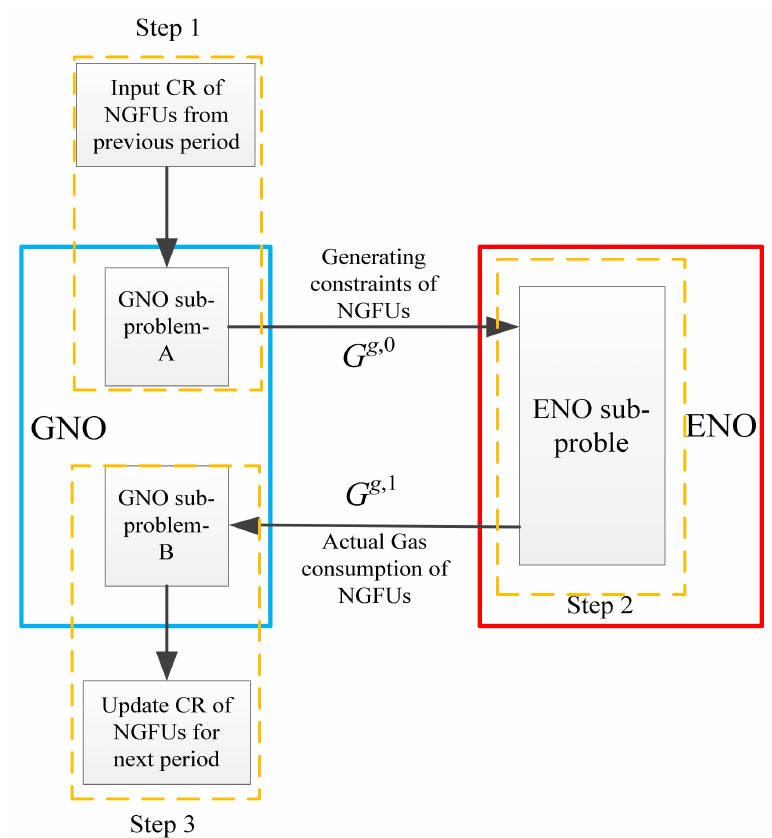
Figure 5. The structure of proposed CO